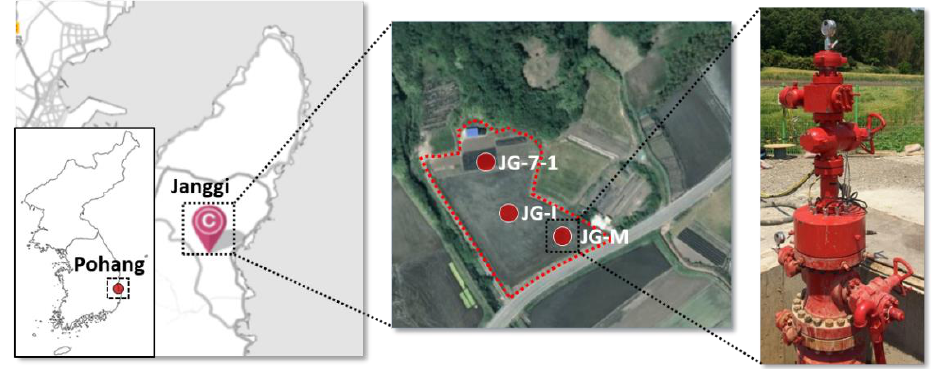
Figure 1. Location of Janggi field site including relative position of auxiliary monitoring well (JG-7-1), monitoring well (JG-M) with its wellhead, and injection well (JG-I).